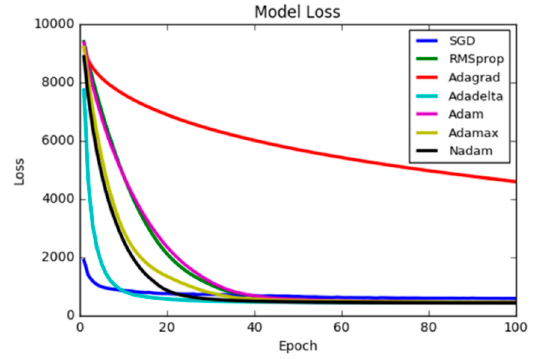
Figure 9. Comparison of training result in different optimizer.